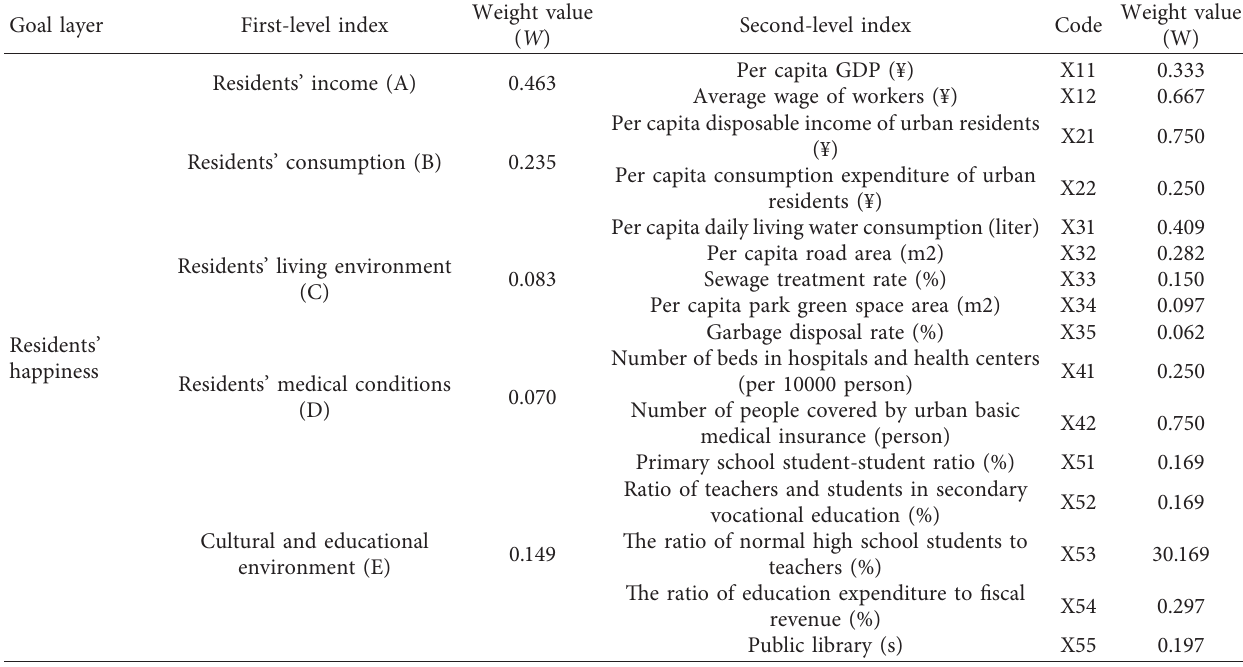
Table 8: Weighting table of residents’ happiness evaluation